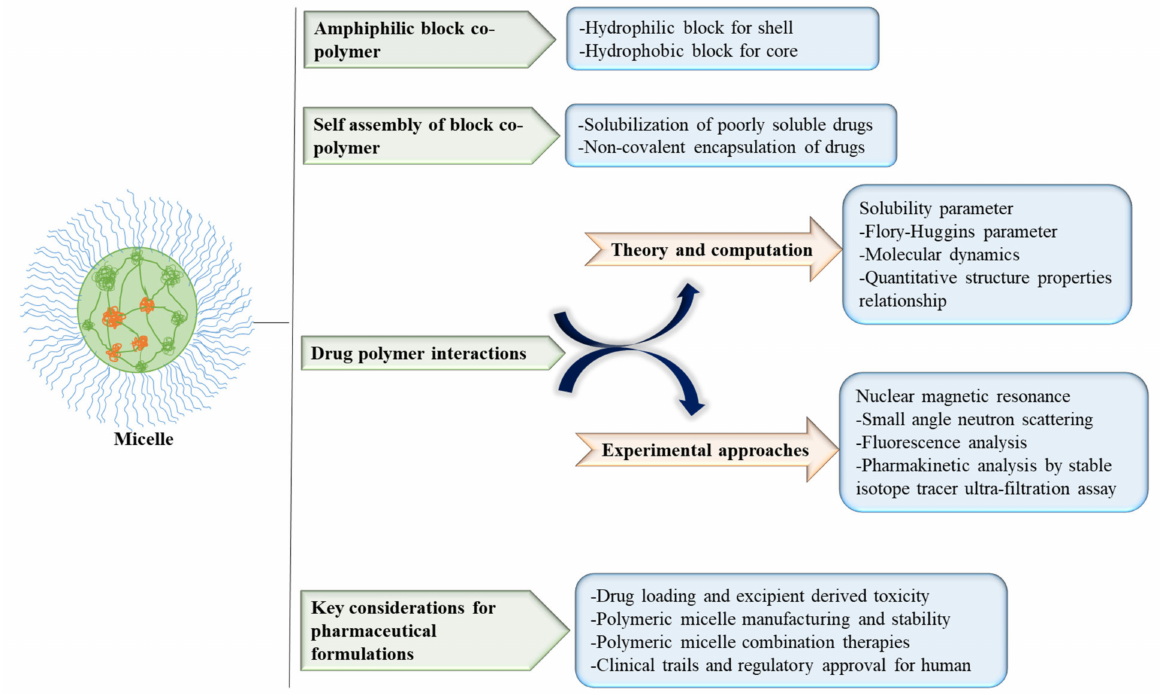
Figure 2. Use of Micelle nanoparticles for efficient drug delivery system and their